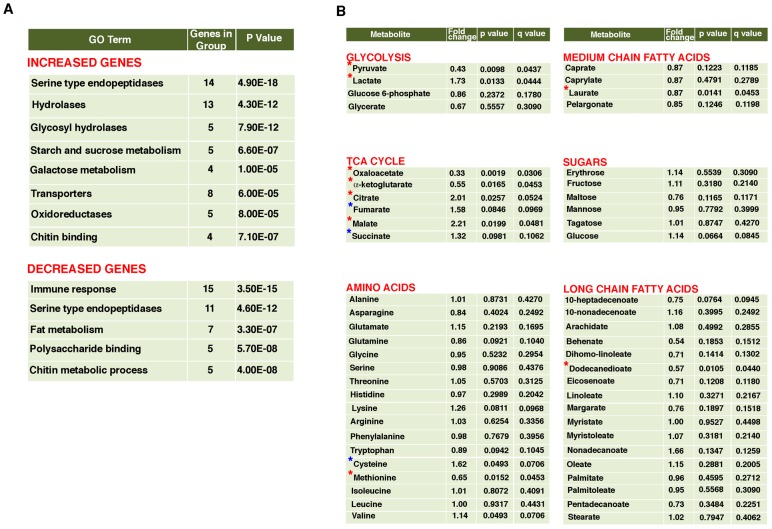
Metabolic reprogramming in dcerk1 mutants.A. Functional classification of genes whose expression is altered in dcerk1 mutants compared to control w1118
 flies. RNA extracted from control and mutant flies was hybridized to Affymetrix Drosophila 2.0 microarrays and experiments were carried out in triplicate. Gene expression analysis revealed 152 genes were increased (2-fold or more) and 158 genes were decreased (0.5 fold or less) in dcerk1 compared to w1118. DAVID gene functional annotation tool and functional classification tool were used to annotate and classify the increased and decreased genes into functionally related gene groups. The top GO terms obtained for increased and decreased genes are listed along with the number of genes altered in each category and the statistical significance based on modified Fisher Exact P-Value. Serine type endopeptidases and hydrolases are upregulated while immune response genes are downregulated in the mutant. B. Metabolomic profiling reveals changes in glycolysis and TCA cycle metabolites in dcerk1 compared to w1118. Control and mutant fly extracts were subjected in triplicate to GC/MS, LC/MS and LC/MS/MS platforms to compare relative levels of several metabolites. The fold change, dcerk1/w1118 is shown for each metabolite. A p value of <0.05 and a q value of <0.1 (false discovery rate) is considered highly statistically significant (marked by a red *). Among glycolysis intermediates, pyruvate and lactate meet these stringent criteria; pyruvate level is decreased while lactate level is increased in the mutant. Among TCA cycle metabolites, oxaloacetate and α-ketoglutarate are decreased while citrate and malate are increased. Fumarate and succinate are also increased and meet the less stringent statistical criteria of approaching significance (p 0.05 −0.1 and q 0.1 or less, marked by a blue *). Most amino acids (other than cysteine and methionine) and sugars do not show significant differences. Among fatty acids, Dodecanedioate, a long chain fatty acid is decreased significantly in the mutant. This could be due to its degradation to acetyl CoA and succinate, the latter being important for gluconeogenesis during starvation.